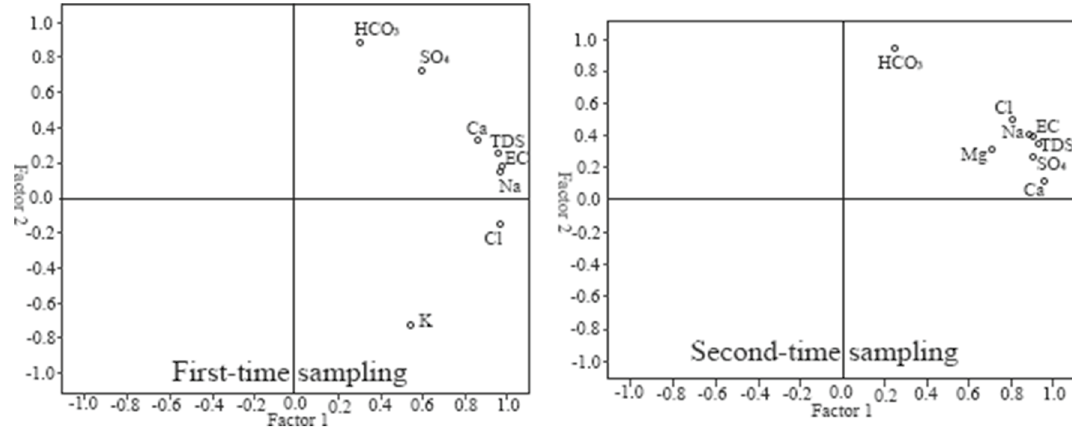
Fig. 9 Plot of initial eigenvalues for studied parameters in the lake and downstream of the Gotvand-e-Olya